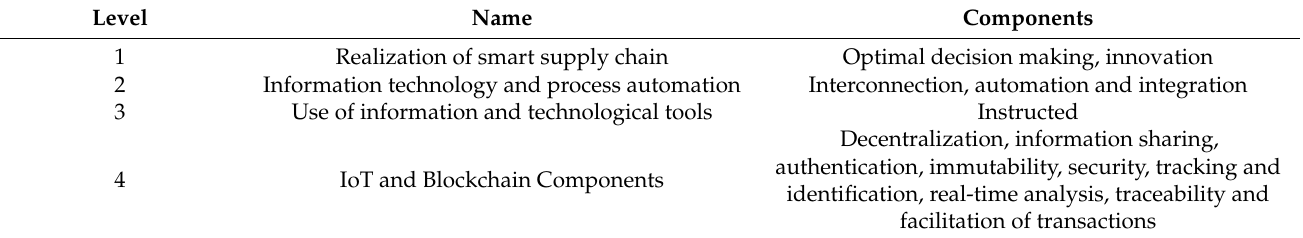
Table 8. The four levels of interpretive structural modelling techniques.